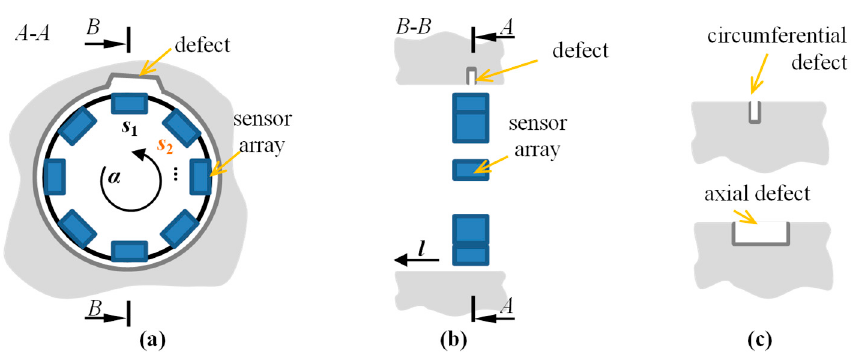
Figure 1. Visualization of multisensor array arrangement inside a steel sample with depicted circumferential α and axial l directions: cross sections in ( a ) circumferential A-A and ( b ) axial B-B planes of the sensor array; ( c ) cross section in the axial plane of two types of examined defects.